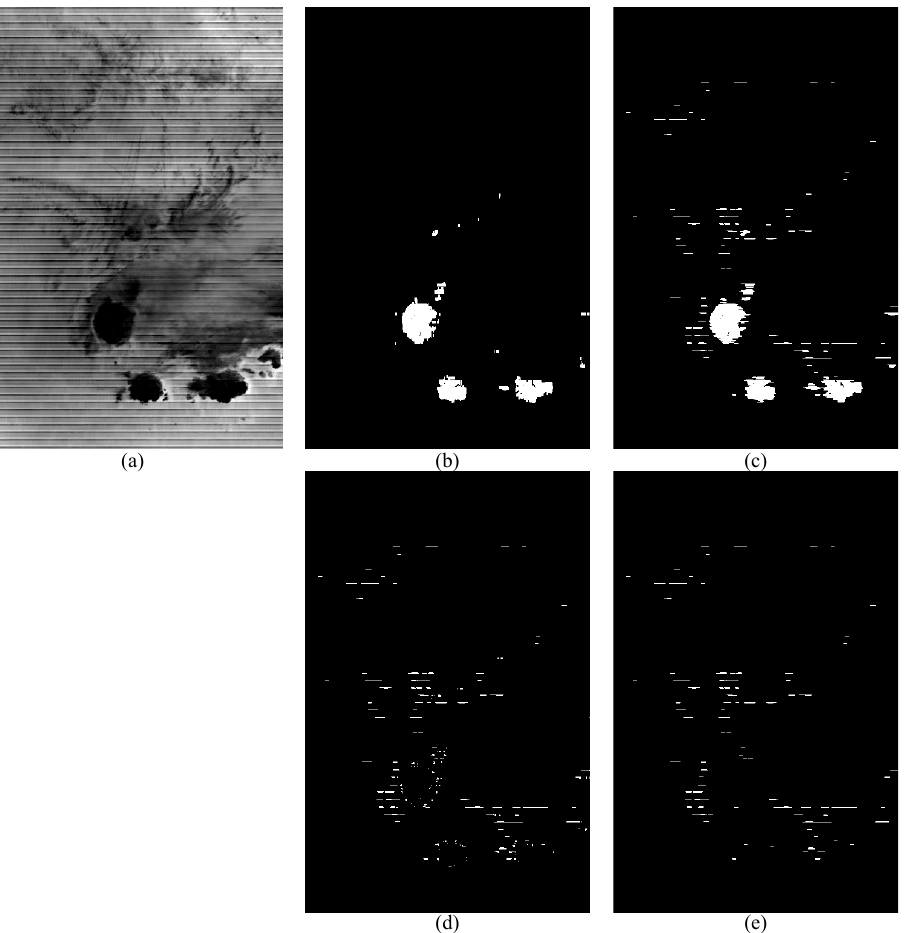
Figure 4. Illustration of extremely dark area and extremely dark stripe detection. ( a ) original subimage extracted from Terra data; ( b ) extreme area in vertical; ( c ) extreme area in horizonal; ( d ) initial extreme dark stripe; ( e ) refined extreme dark